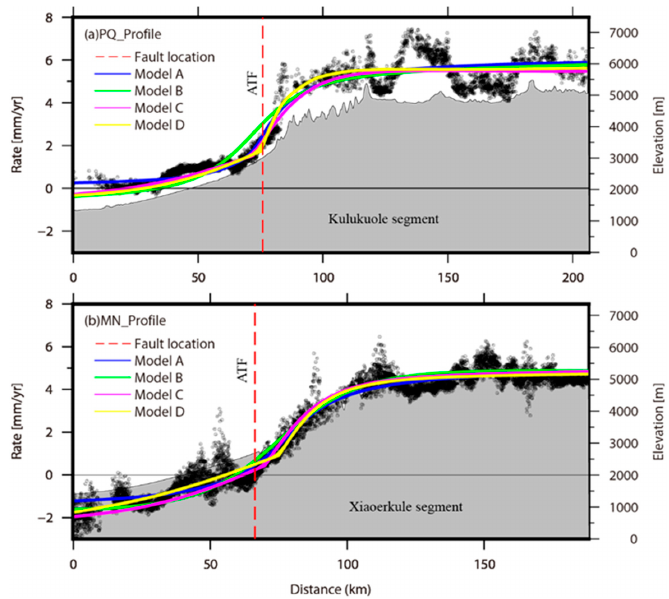
Figure 9. Model prediction from four types of models constrained by the horizontal velocity profiles. ( a ) for profile PQ and ( b ) for profile MN. The location of the profile is shown in Figure 4a. Blue, green, pink, and yellow curves are model predictions from Model A, B, C, and D, respectively.